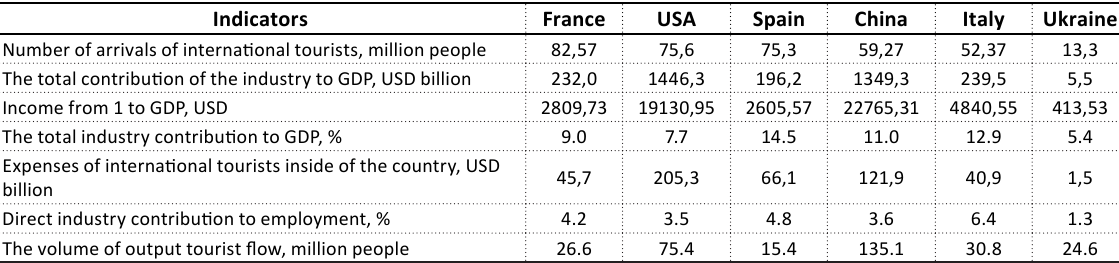
Table 3. Key indicators of tourism industry development in 2016